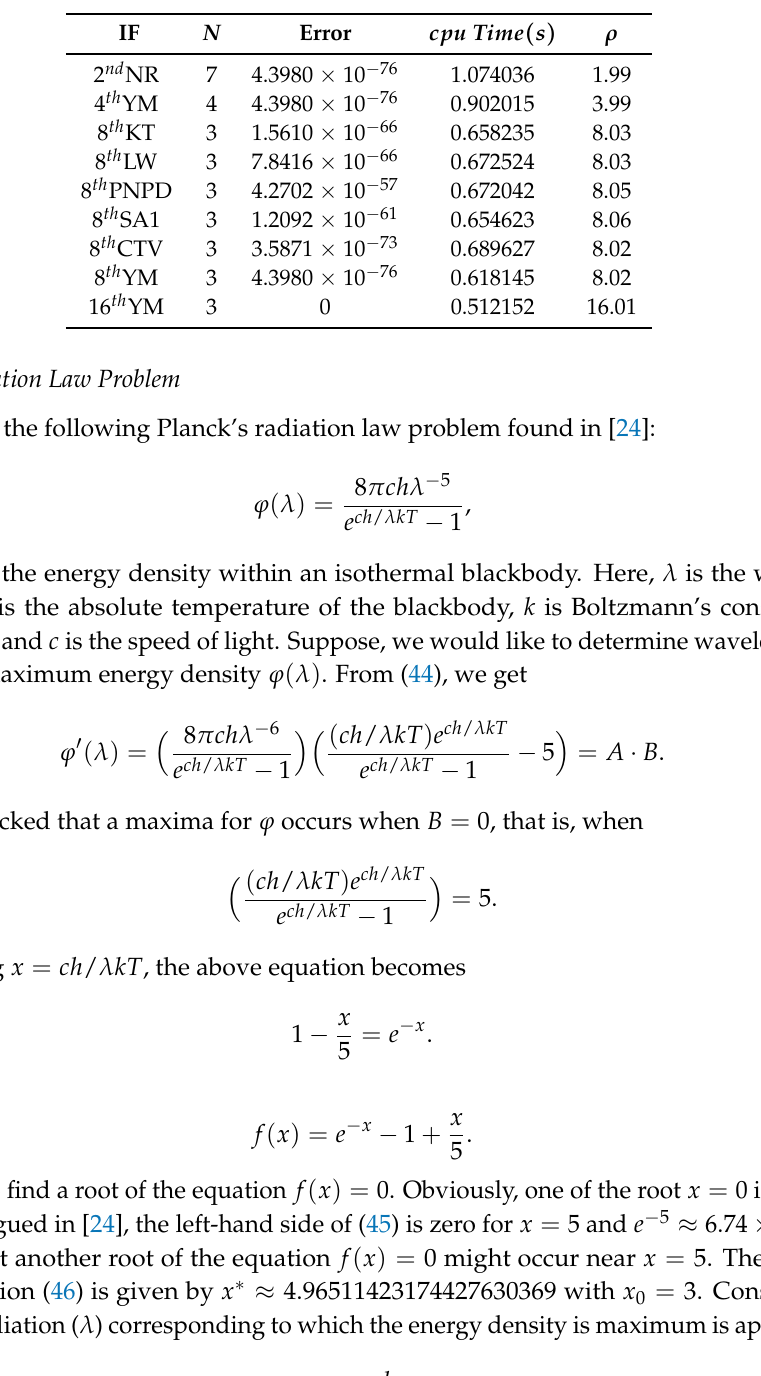
Table 6. Results of projectile